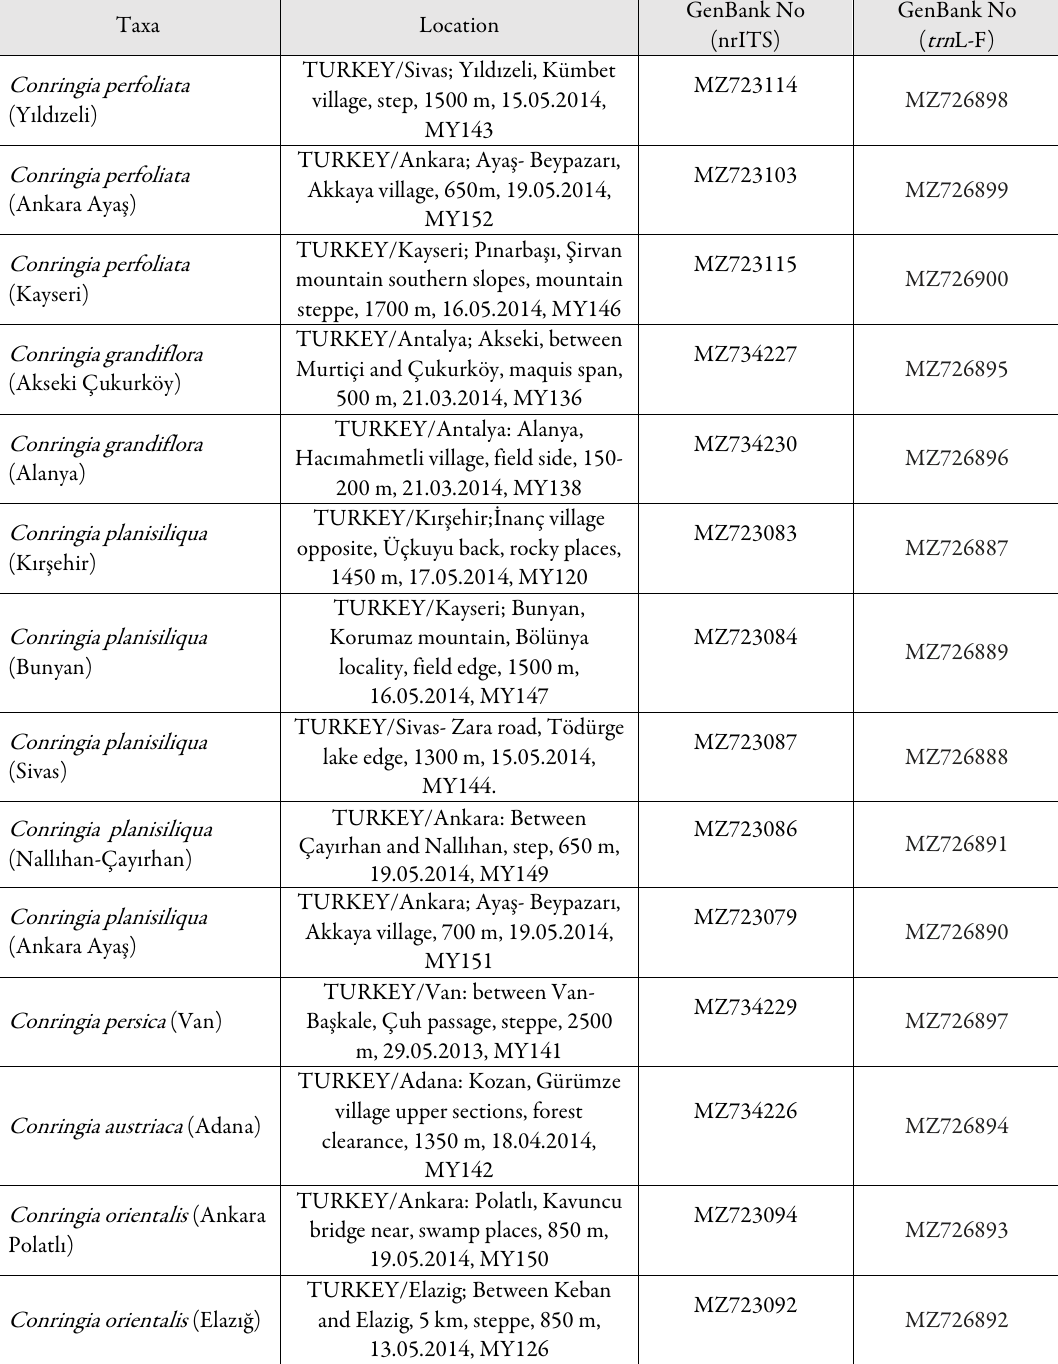
Table 1. Location of Conringia species in